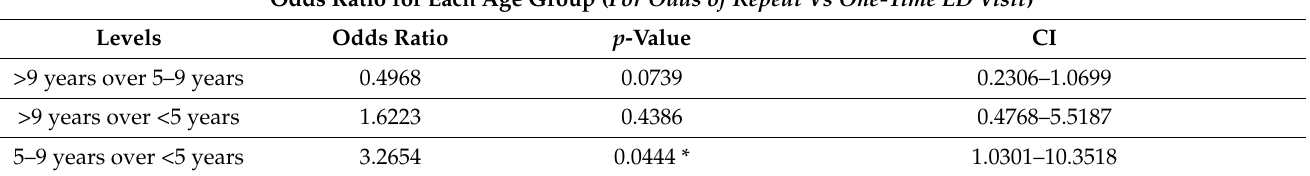
Table 4. Logistic regression analysis (Round 1 analysis: 0 – 17 years).